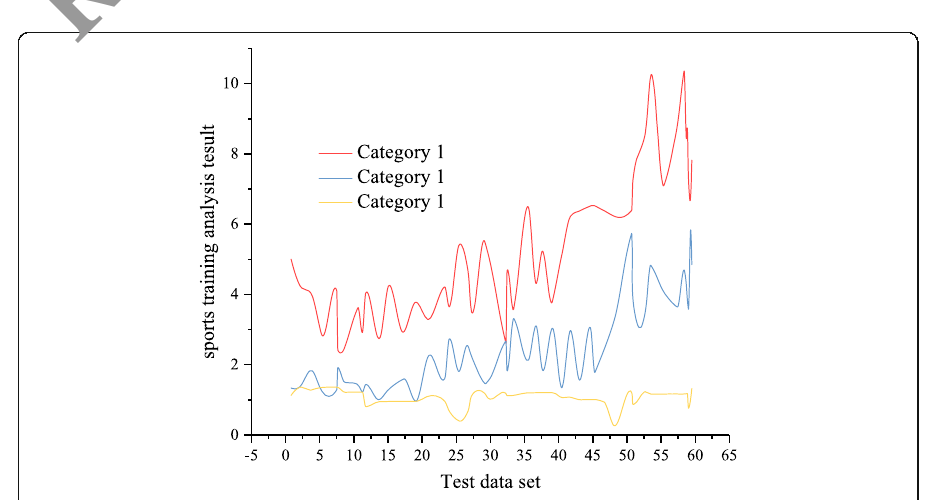
Fig. 5 System test — the number of lost packets in the